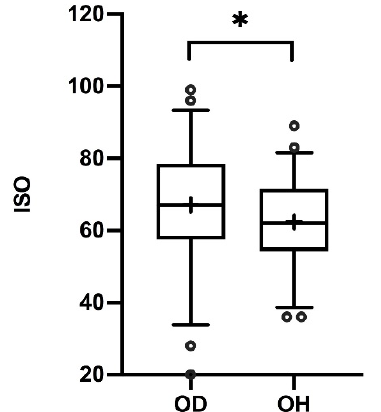
Figure 2. Box-and-whisker plots of scores on the questionnaire of individual significance of olfaction (ISO). Medians (Q0.5; line), interquartile range (Q0.25, Q0.75; boxes); + mean scores; ◦ outliers. Scores of subjects with olfactory disfunction (OD) and subjectively olfactory-healthy (OH) subjects differed significantly: * p = 0.0382.